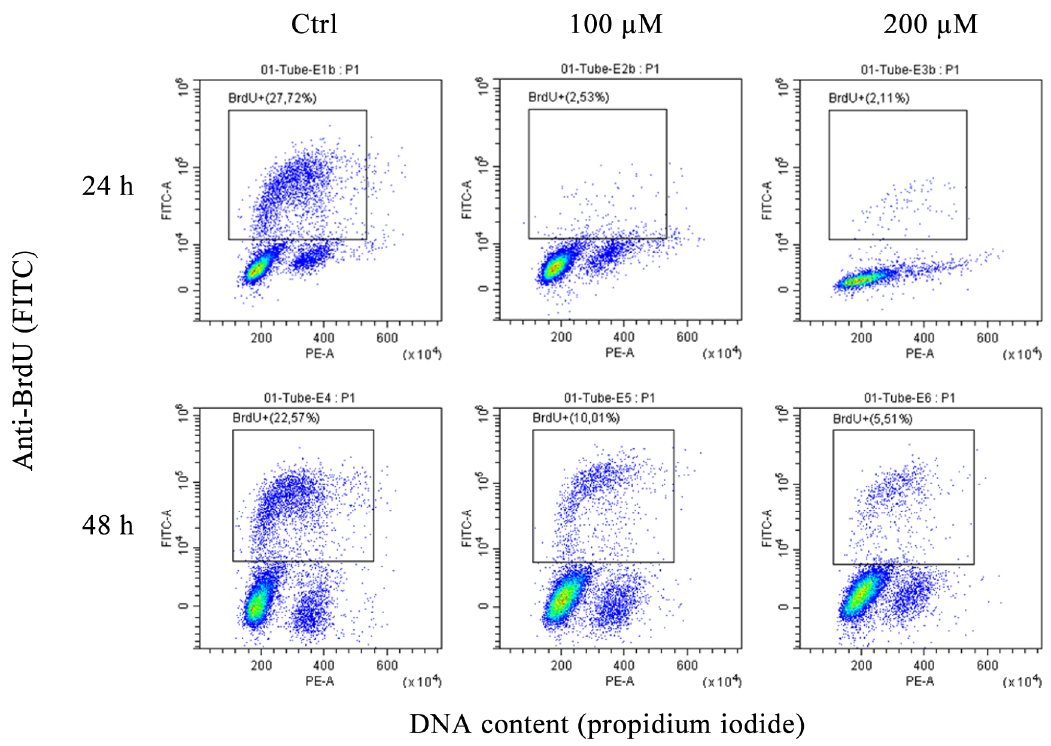
Figure 6. Cytometric analysis of BrdU incorporation. The incorporation of BrdU was used to detect the cell proliferation status by flow cytometry. In this figure, biparametric dot plots of control or H 2 O 2 -treated MRC-5 cells show that this treatment, at 24 h ( A ), completely arrested cell proliferation. Which was slightly recovered at 48 h ( B ). The magnitude of this cell cycle arrest effect is dose related. The box gate on dot plots represents BrdU-positive cells.